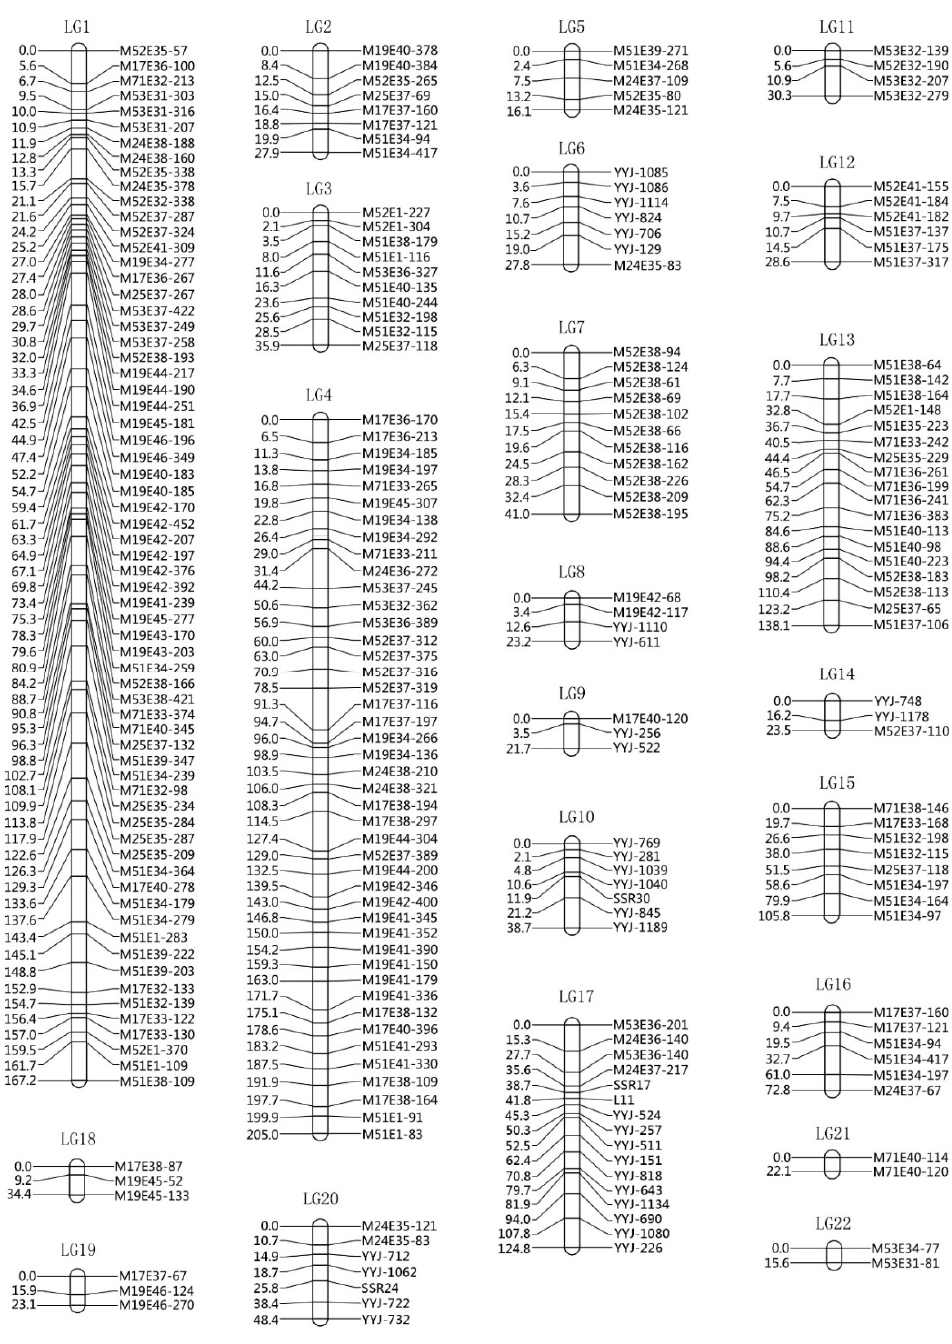
Figure 2. The genetic linkage map of Lagerstroemia derived from the BC 2 populations. Map distances are shown in cm on the left of each linkage group and molecular markers are on the right side of each linkage